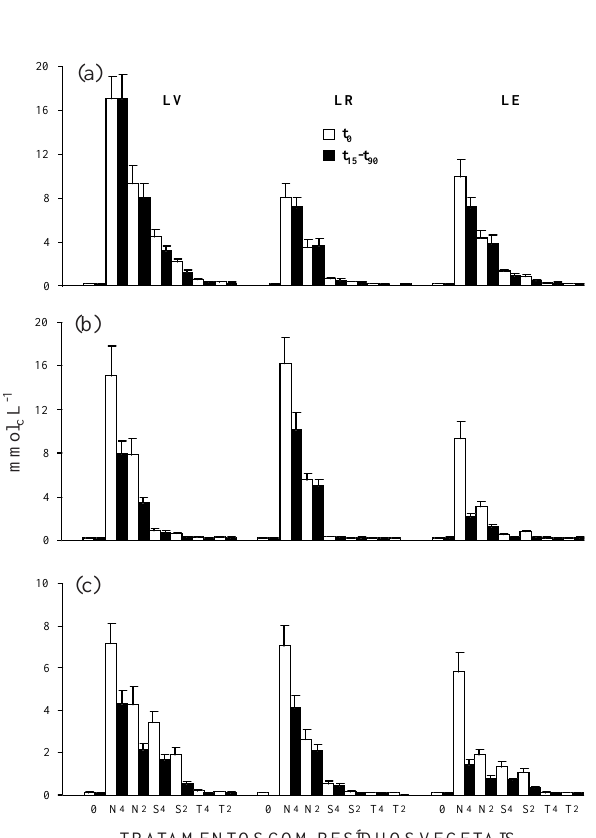
Figura 3. Efeito da adição de resíduos vegetais em solos ácidos nos teores de K (a), Ca (b) e Mg (c) solúveis. t : tempo inicial; t t : valores médios 0 15- 90 de t , t , t e t . Barras verticais indicam o 15 30 60 90 erro-padrão da